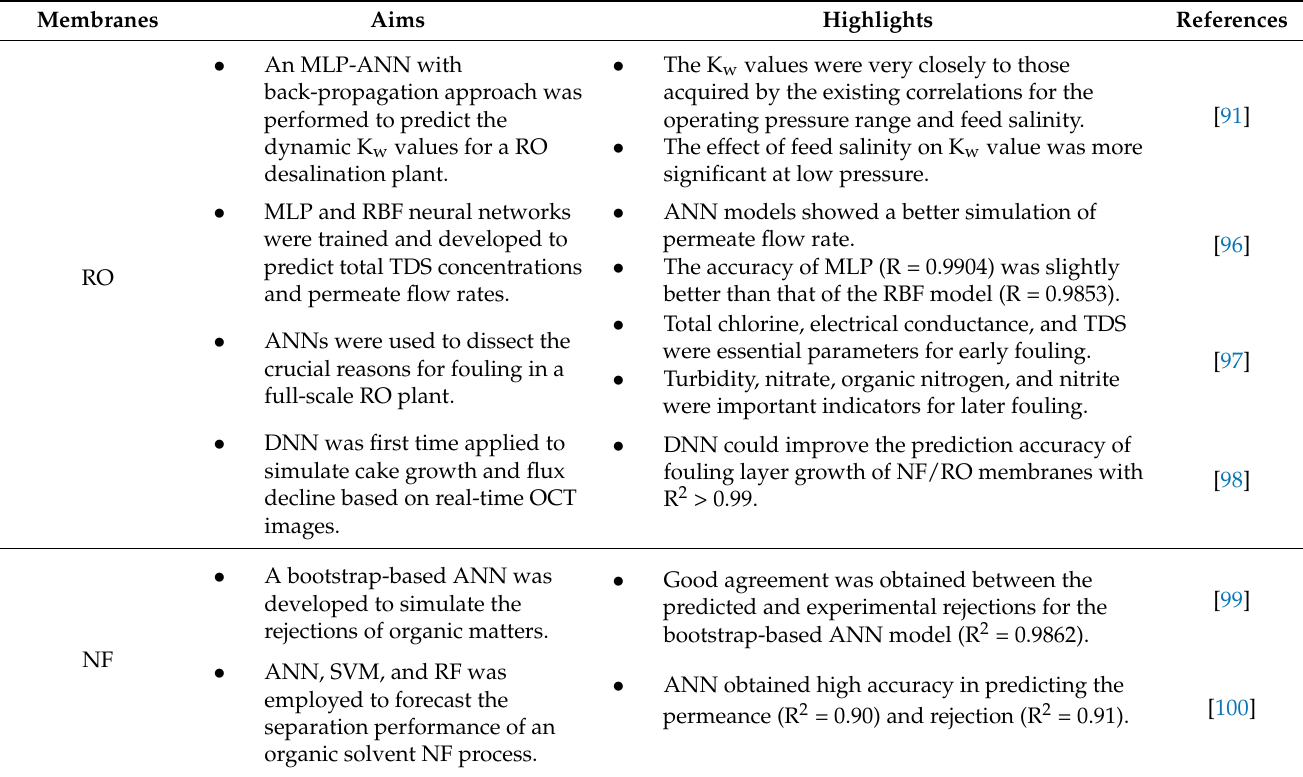
Table 3. Application of ANNs for fouling simulation in different membrane system from the literature. Membranes Aims